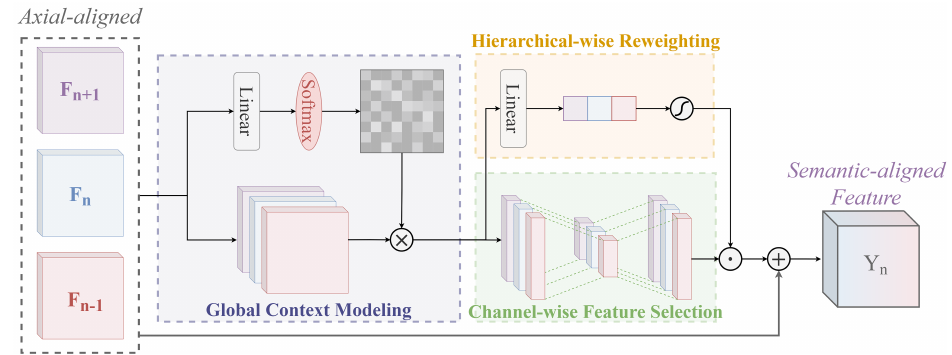
Figure 6. The structure of hierarchical-wise context fusion